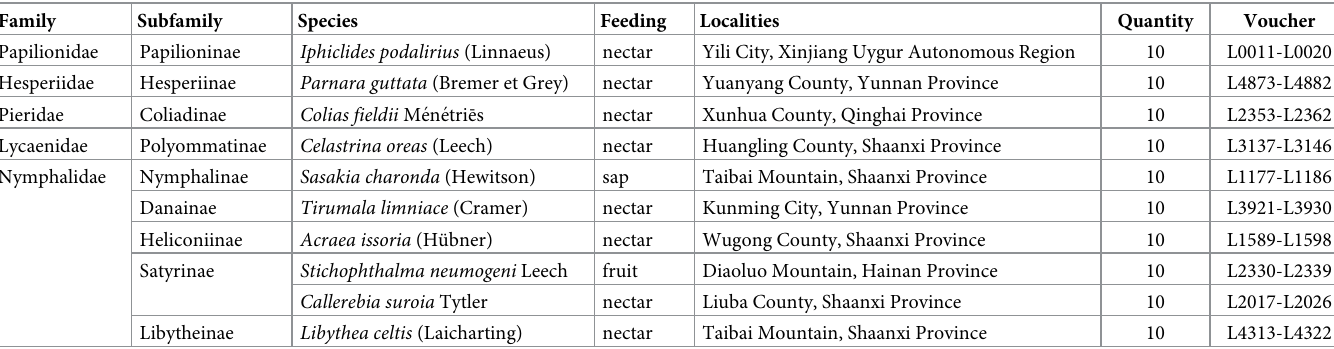
Table 1. Material localities and collection